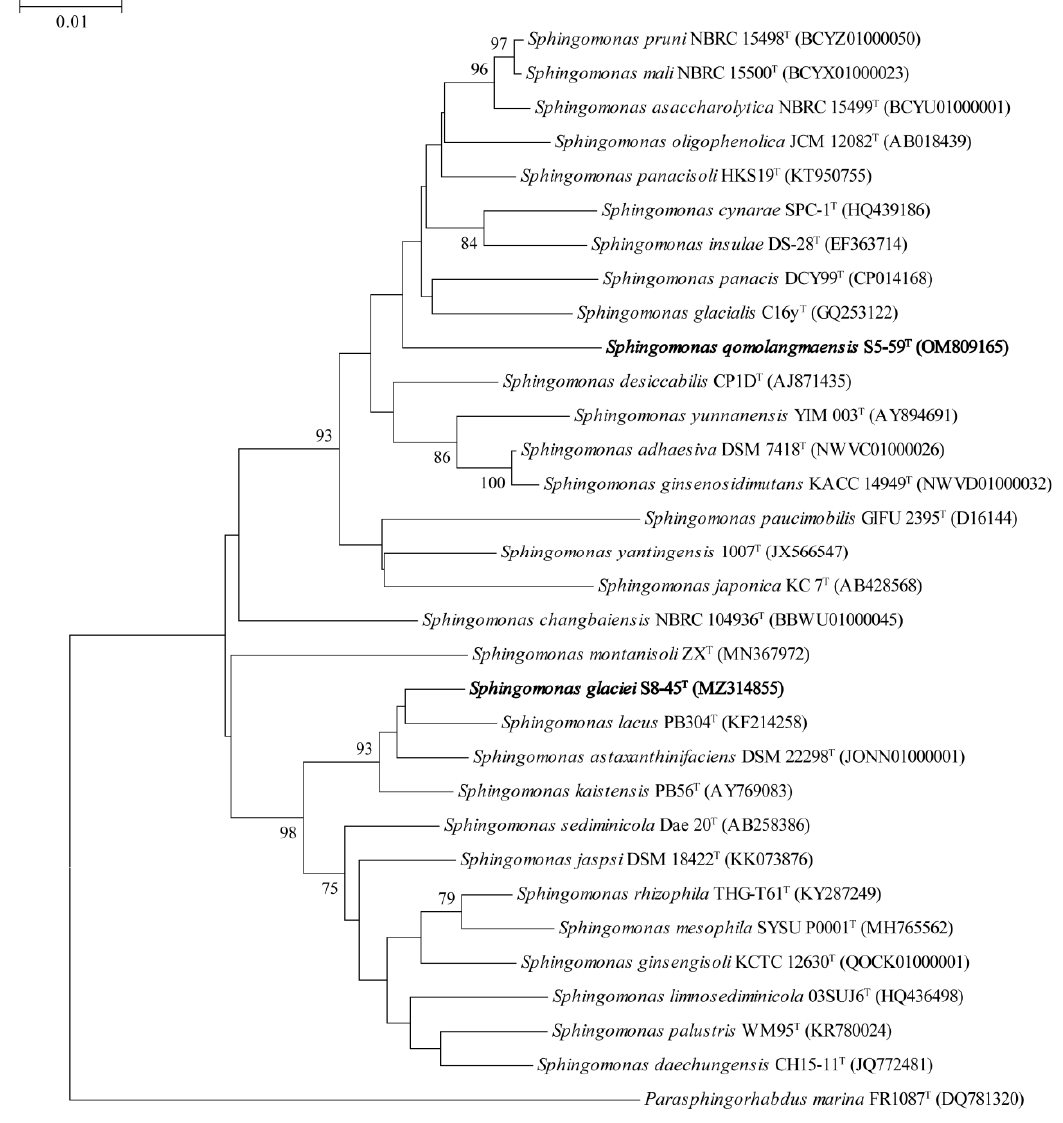
Figure 1. Neighbor-joining phylogenetic tree based on 16S rRNA gene sequences of the strain S5- 59 T , S8-45 T , and the type strains of other closely related species in the genus Sphingomonas and Parasphingorhabdus . Parasphingorhabdus marina FR1087 T (DQ781320) was used as an outgroup. The numbers on the tree indicate the percentages of bootstrap sampling derived from 1000 replications and the bootstrap values higher than 70% are shown. Bar, 0.01 substitutions per nucleotide position.